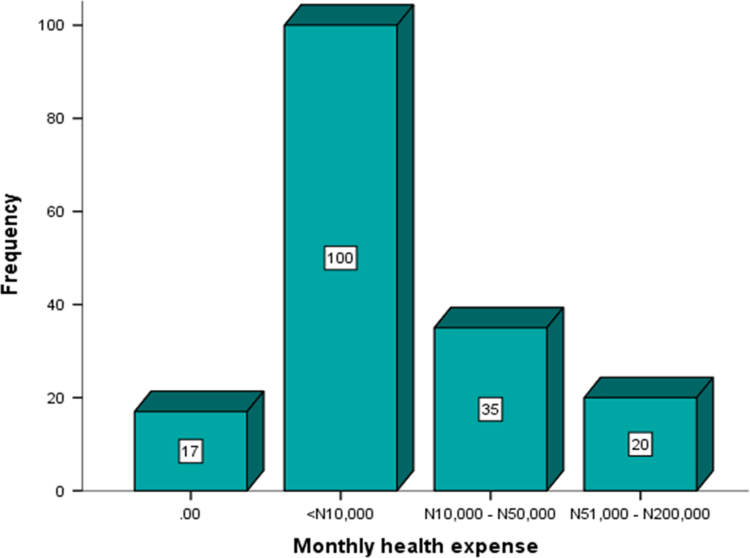
Average monthly medical cost reportedly incurred by all respondents.